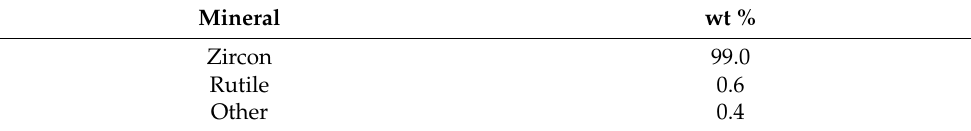
Table 8. Mineralogical composition of zircon concentrate.